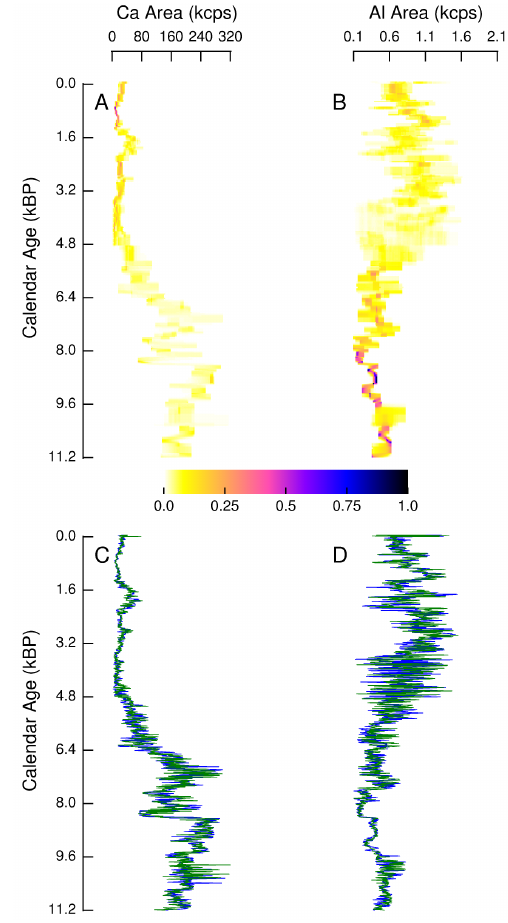
Figure 9. Posterior probability distribution and proxy ensemble members. (a, b) The posterior proxy distributions for Ca area (in Fig. 9. Posterior probability distribution and proxy ensemble mem- a ) and Al area (in b ) obtained by our approach. At every chosen bers. A, B. The posterior proxy distributions for Ca-area (in A ) and value of the calendar age on the vertical axis, our method provides Al-area (in B ) obtained by our approach. At every chosen value of a probability distribution for the proxy along the horizontal proxy the calendar age on the vertical axis, our method provides a proba- axis. The probabilities are indicated by the color bar, with white bility distribution for the proxy along the horizontal proxy axis. The representing zero probability. (c, d) Two randomly chosen ensem- probabilities are indicated by the color-bar, with white representing zero probability. C, D. Two randomly chosen ensemble members ble members (blue and green curves) for Ca area (in c ) and Al (blue and green curves) for Ca-area (in C ) and Al-area (in D ) out area (in d ) out of all possible proxy records given the probability of all possible proxy records given the probability distributions in distributions in (a) and (b) , respectively. Such individual ensemble A and B respectively. Such individual ensemble members retain the members retain the high-frequency components as well, indicating high frequency components as well, indicating that the high fre- that the high-frequency information is still contained in the poste- quency information is still contained in the posterior probabilities. rior probabilities. (Color (Color online.)